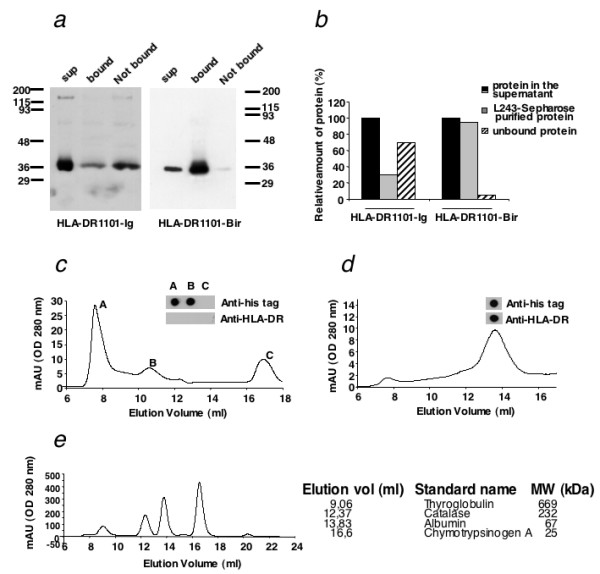
Soluble recombinant HLA-DR*1101-Ig and HLA-DR*1101-Bir molecules display different biochemical properties. Characterization of the native structure and stability of both soluble recombinant HLA-DR*1101 molecules. (a) Immunoprecipitation of HLA-DR*1101-Ig and HLA-DR*1101-Bir molecule with 30 μl of L243-sepharose beads from 1 ml of S2 cells culture supernatant after CuSO4 induction. The lanes contain the following material: 1. sup, 30 μl of culture supernatant before immunoprecipitation; 2. bound, the immunoprecipitated soluble recombinant HLA-DR*1101; and 3. not bound, 30 μl of culture supernatant after immunoprecipitation. Proteins were separated on SDS-page, transferred to filter and revealed with anti his-tag antibody. (b) Densitometric analysis of the protein bands displayed in panel (a), showing the elative efficiency of immunoprecipitation of the two soluble recombinant HLA-DR*1101 proteins with L243-Sepharose beads, as an indirect indicator of the percentage of correctly folded molecule. (c) Size exclusion chromatography of HLA-DR*1101-Ig molecules, after purification of ProtA affinity chromatography. The elution profile of the molecule from a Superdex 200 gel filtration column is shown. Inset shows the dot-blot analysis performed on the protein contained in the indicated elution peaks. Spotted proteins are probed with either anti-His tag antibody, to verify the presence of the HLA-DR*1101 molecule, or L243 mAb (Anti-HLA-DR) to verify the correct conformation of the molecule. (d) Elution profile from Superdex 200 gel filtration column and dot-blot analysis on eluted peaks of HLA-DR11-Bir molecules, performed as described in (c). (e) Calibration profile of the Superdex 200 gel filtration column.